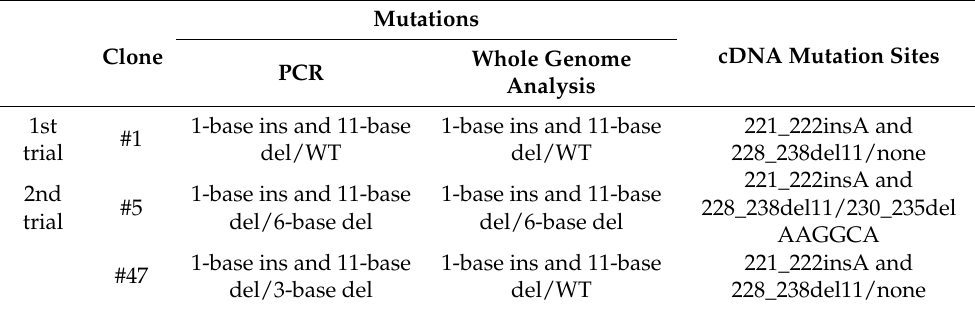
Table 1. Mutation sites of clones by